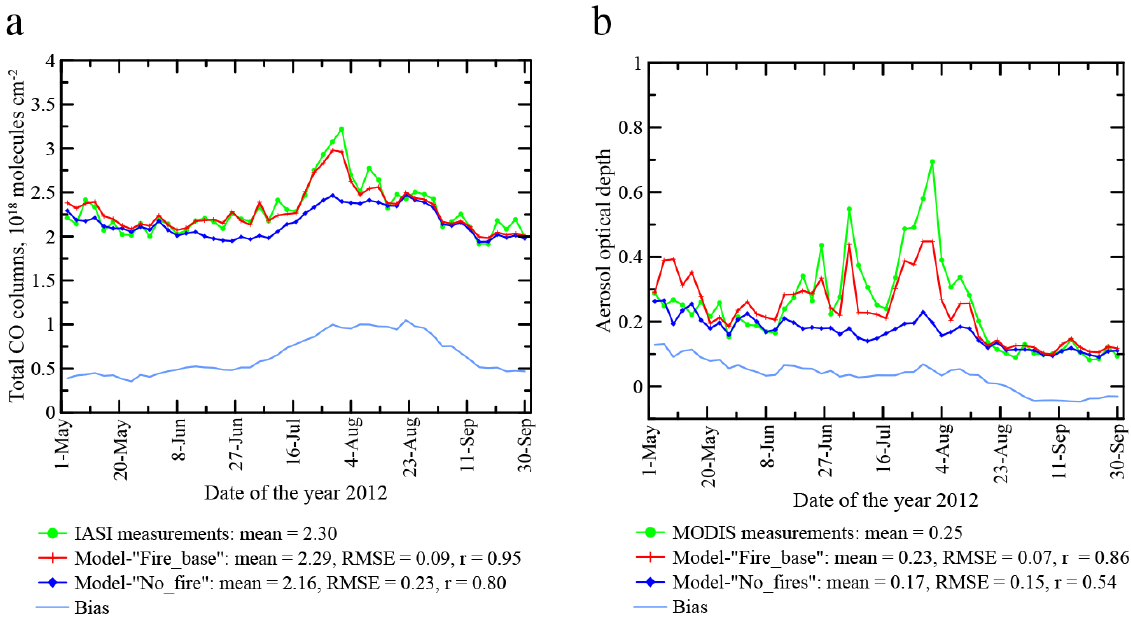
Figure 7. Time series of (a) daily total CO columns and (b) AOD simulated by CHIMERE with (“Fires_base”) and without (“No_fires”) fire emissions in comparison to the data from the corresponding IASI and MODIS measurements. The measurements and simulations for the days shown were withheld from the emission estimation procedure. The simulations are presented after debiasing. Note that the indicated bias represents the values of 1 (see Sect. 2.3) taken with the opposite sign. All values are the averages over the Siberian study